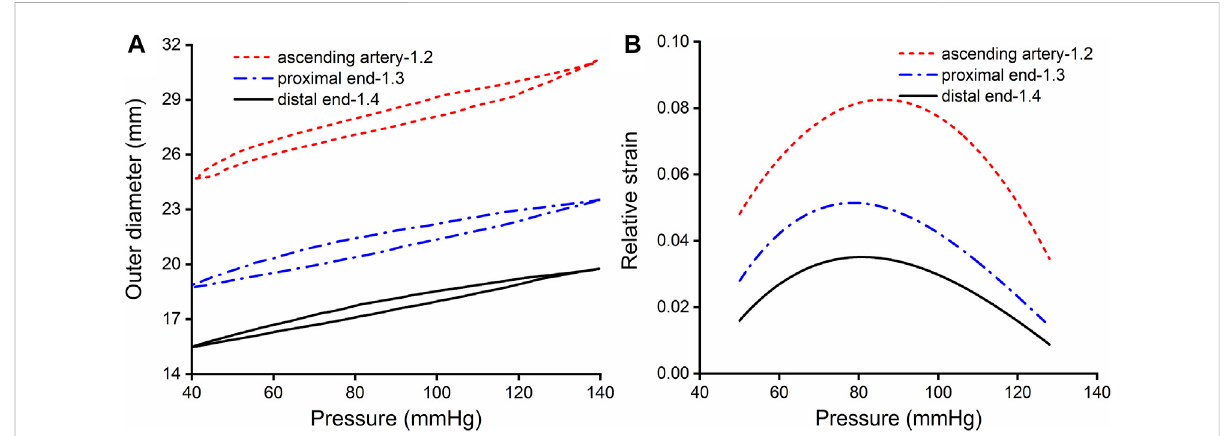
FIGURE 1 Results of expansion andextensiontests. (A) Outer diameter-pressure curves of theaorta, withan in vivo axialstretchratio of1.2, 1.3and 1.4for the ascending, proximal descending and distal descending aorta, respectively. (B) Relative strain-pressure curves of the ascending, proximal descending and distal descending aorta with an axial in vivo stretch ratio of 1.2, 1.3 and 1.4.